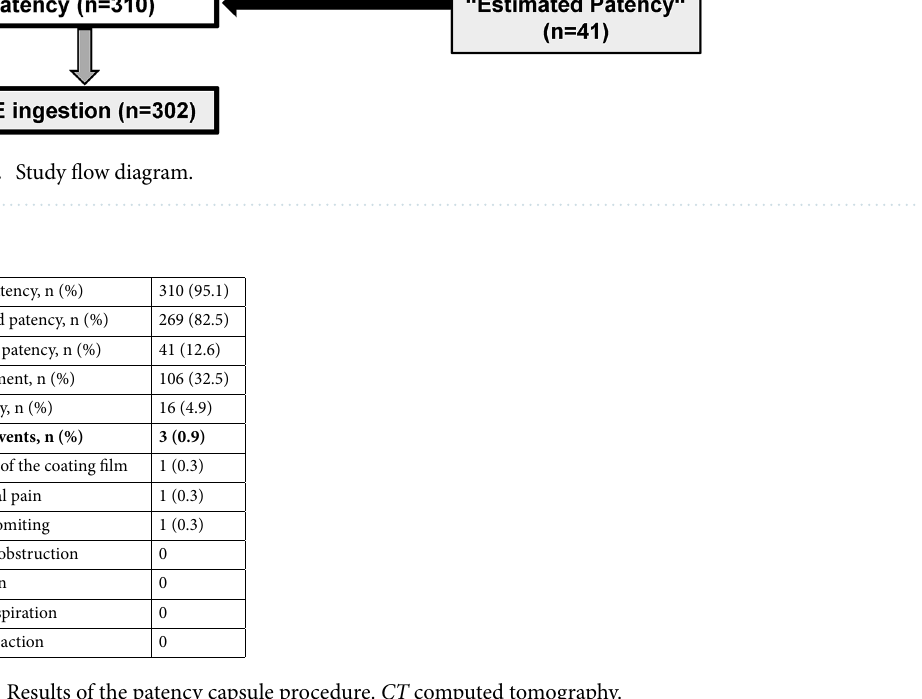
Table 2. Results of the patency capsule procedure. CT computed